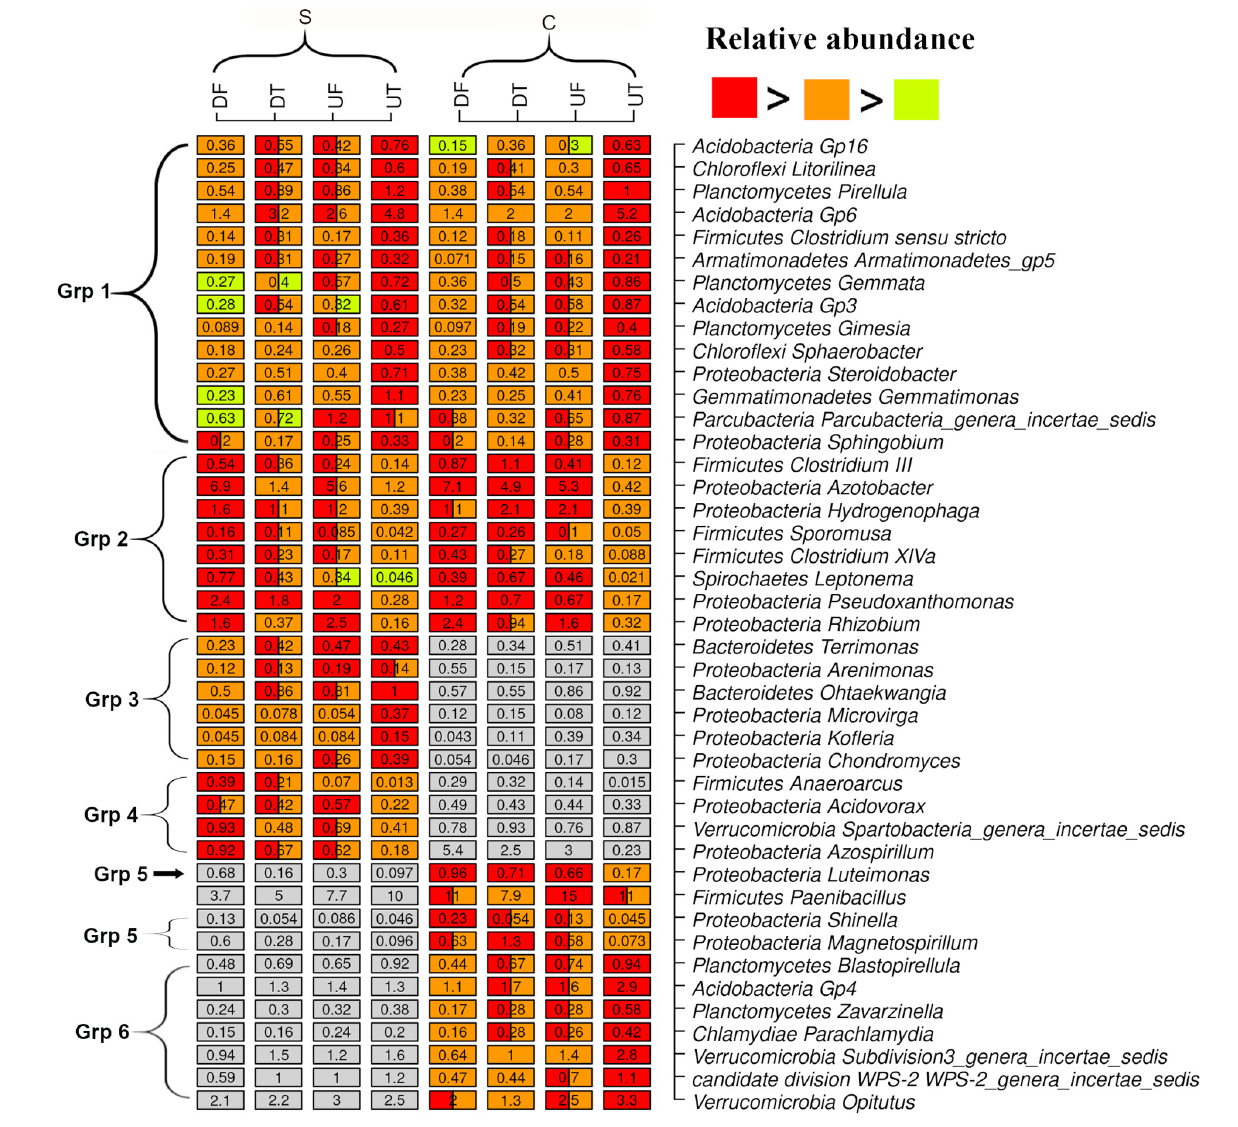
FIGURE 2 | Genera with significantly different relative abundance in the rhizosphere of the upper (U) or lower (L) part of the taproot (T) or fibrous (F) roots treated by the disease-suppressive (S) or non-suppressive soil (C). Significant difference is indicated by a different color. A box with two colors indicates no significant difference from other treatment containing one of the two